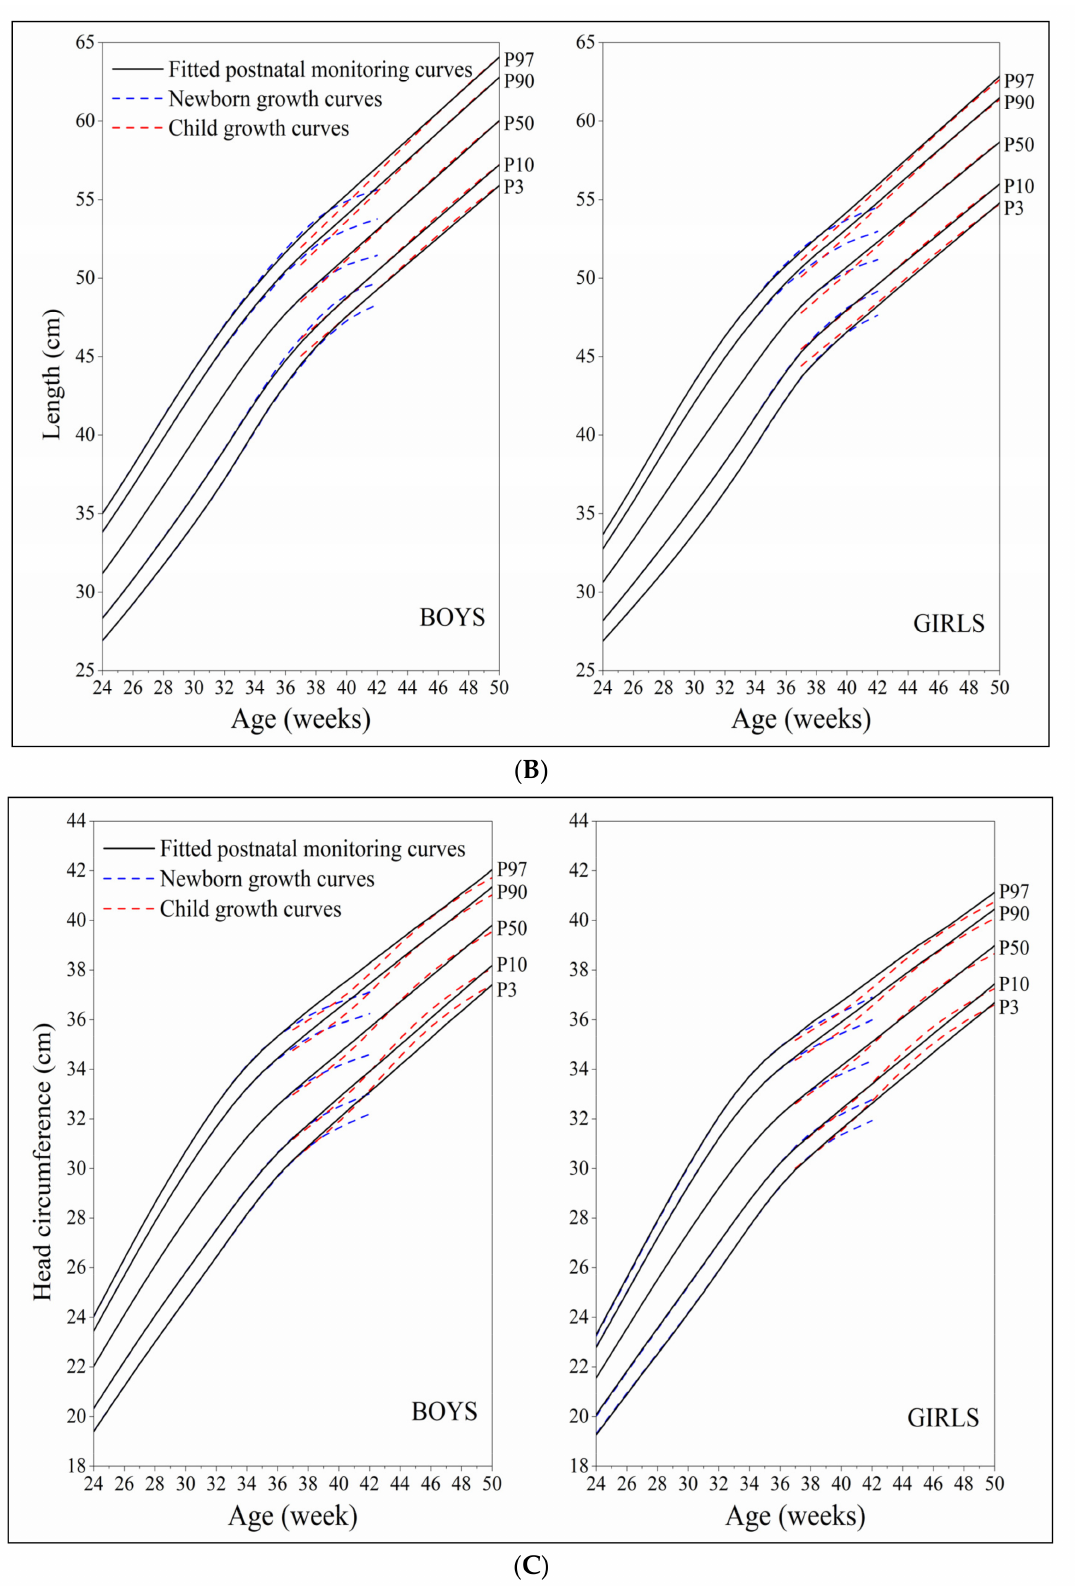
Figure 1. Comparison of the 3rd, 10th, 50th, 90th, 97th percentile curves among fitted postnatal growth monitoring curves, newborn growth curves, and child growth curves; ( A ) weight; ( B ) length; ( C ) head